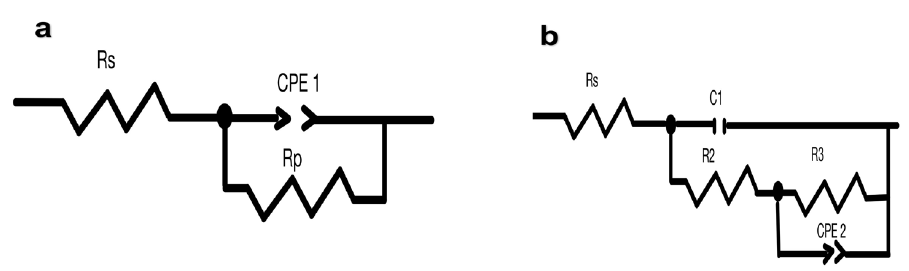
Figure 5. ( a ) Simplified Randles circuit for polished samples; ( b ) proposed circuit for Red Bull and Green Cola samples used to obtain impedance spectroscopy (EIS) data.